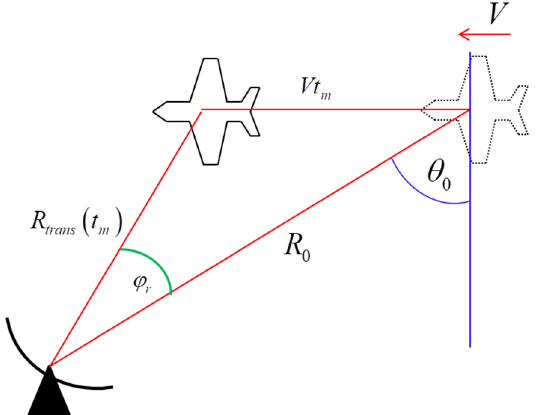
R is the initial distance between 0